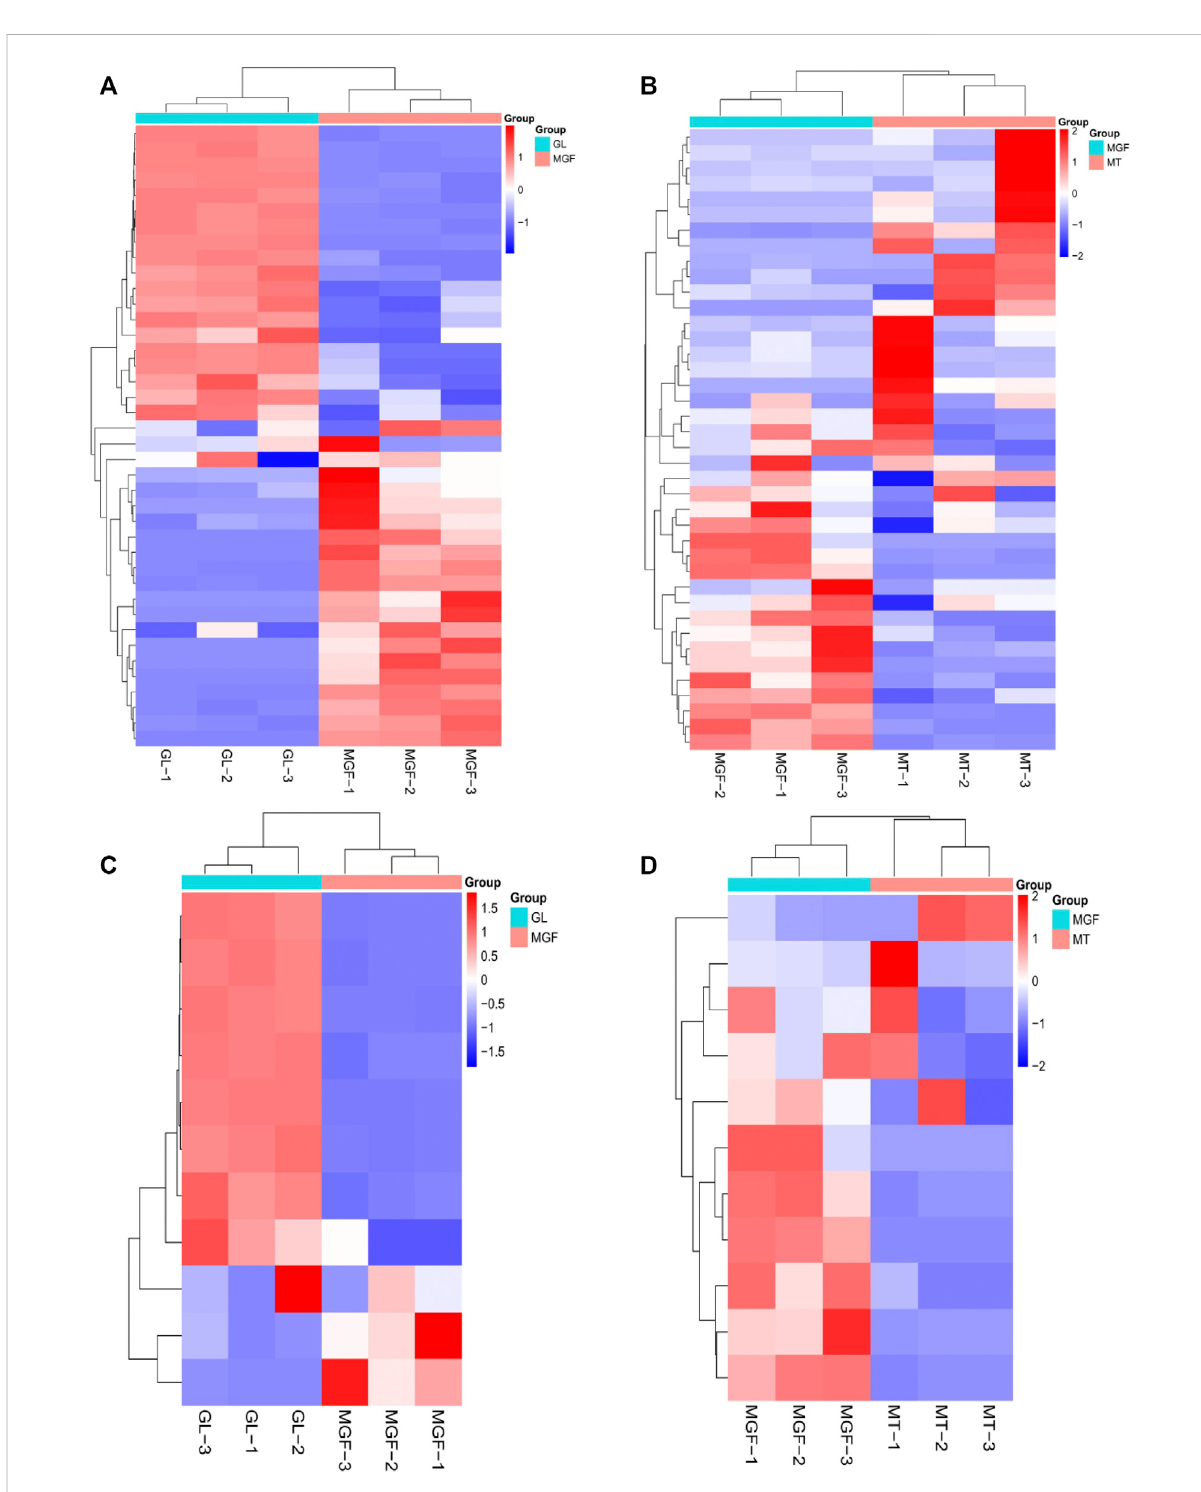
FIGURE 9 Thermograph of differential metabolites between MT and MGF. (A) Organic acids of GL compare MGF. (B) Organic acids of MGF compare MT. (C) Amino acids and derivatives of GL compare MGF. (D) Amino acids and derivatives of MGF compare